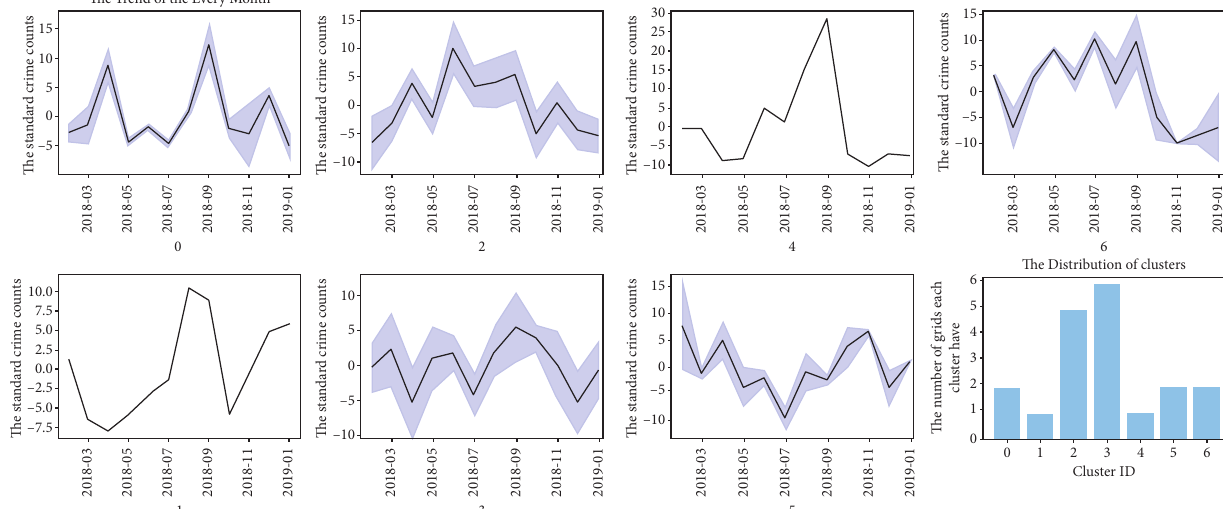
Figure 8: The burglary in San Francisco trends in each month in 2018 and the distribution of clusters. The line charts are the monthly trends of burglary in San Francisco in 2018. The bar chart is the distribution of the